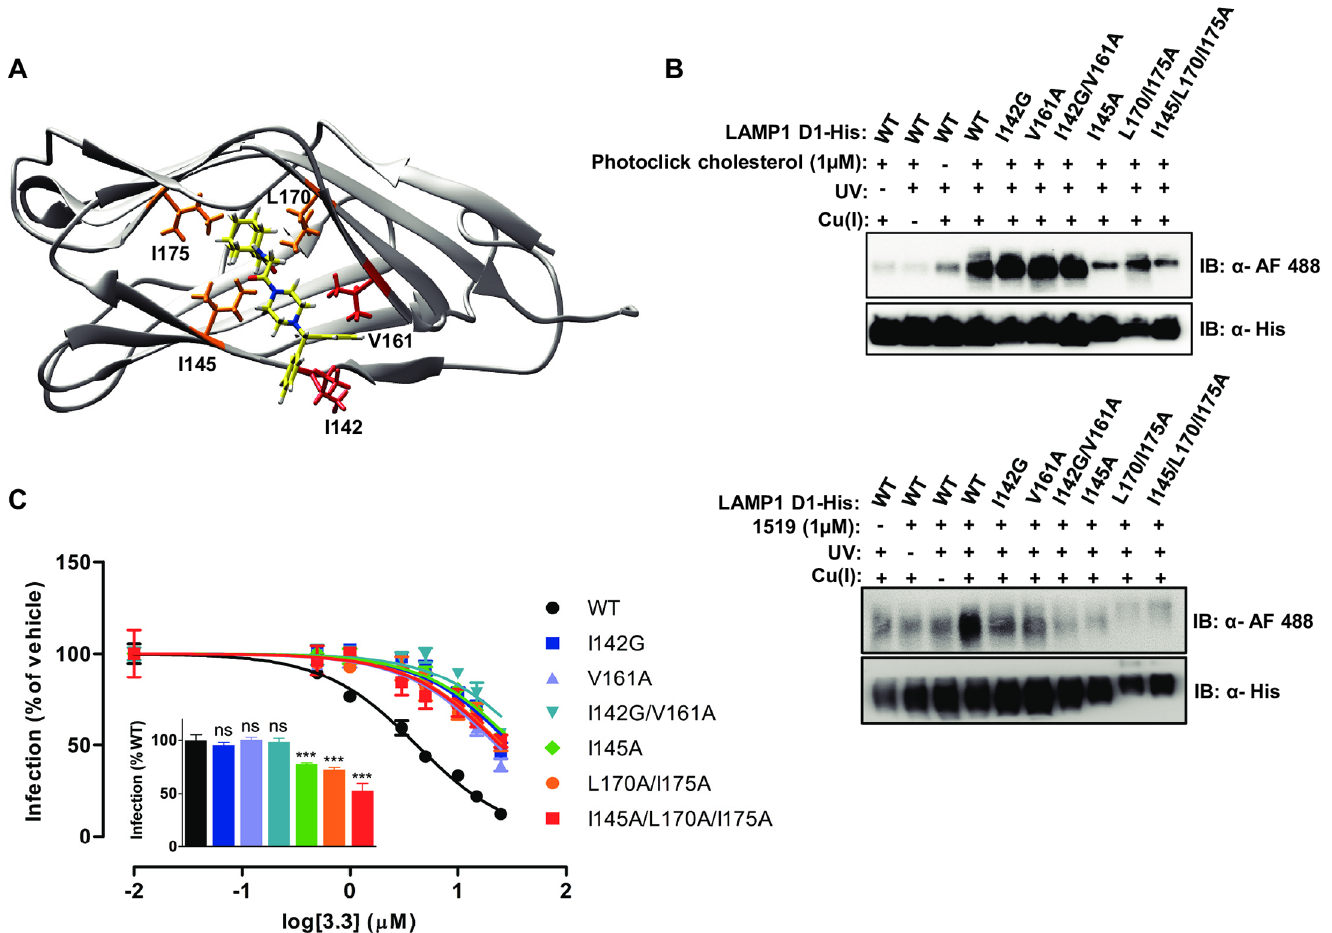
Fig 5. 3.3 binding to the hydrophobic central pocket of LAMP1 D1. (A) Docking of 3.3 (yellow) in the predicted structure of LAMP1 D1. Residues within the hydrophobic pocket predicted to contact 3.3 are colored orange. Residues on the surface at the edge of the pocket predicted to contact the diphenyl group of 3.3 are colored red. (B) Mutational analysis of predicted 3.3 contacts with LAMP1 D1 on cross-linking by photoclick cholesterol and by 1519. Purified LAMP1 D1 containing the indicated mutations were incubated with photoclick cholesterol (top) or 1519 (bottom) for 1h at 37˚C prior to UV irradiation and click chemistry with AF 488 azide. Labeled protein was detected by immunoblot with an anti-AF 488 antibody. Input LAMP1 D1 was detected using an anti-His antibody. (C) Mutational analysis of predicted 3.3 contacts with LAMP1 D1 on transduction by MLV LASV GP and 3.3 inhibition. 293T LAMP1 KO cells transfected with the indicated LAMP1 mutants were incubated with the indicated concentrations of 3.3 for 1h before challenge with MLV pseudotyped with LASV GP and encoding GFP. Virus transduction is reported as % of GFP-positive cells relative to cells exposed to DMSO vehicle alone. Inset shows the MLV LASV GP transduction efficiency relative to that on cells transfected with wild-type (WT) LAMP1. Data are mean ± SD ( n = 3). The IC 50 of the WT curve differs significantly from all other curves ( p < 0.001). Inset: ns (not significant); (cid:3)(cid:3)(cid:3) ( p < 0.001). Statistical analyses were performed using one-way ANOVA with Tukey post-hoc analysis.